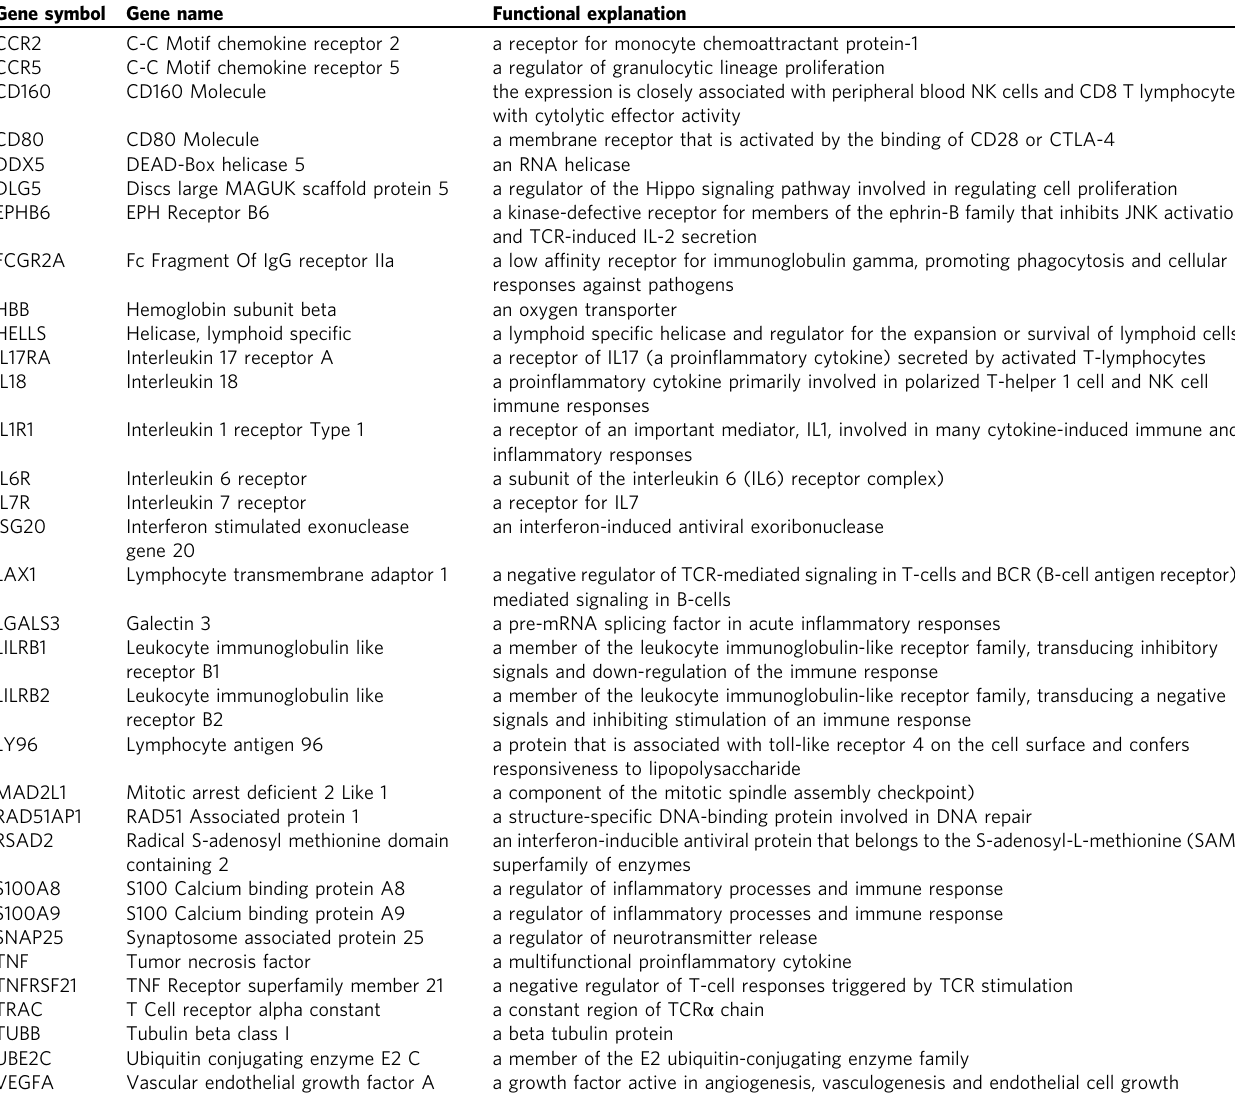
Table 2 Gene names and their actual or hypothetical functions based on GeneCards (The Human Gene Database, https://